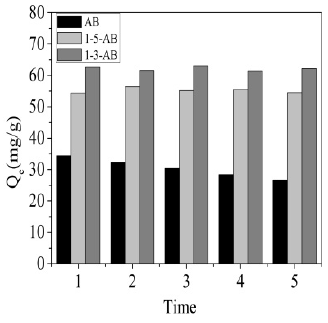
Figure 8. Regeneration cycle performance of AB, 1 ‐ 5 ‐ AB, and 1 ‐ 3 ‐ AB.